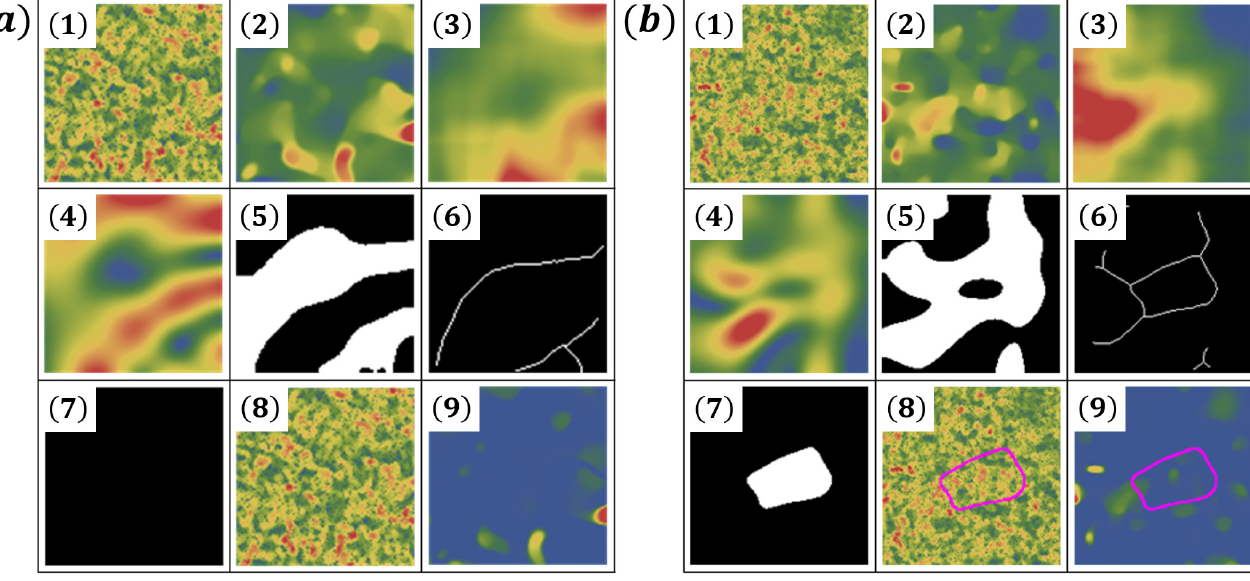
Figure 10. Instances of false positives revealed by MRIF with ( a ) no local segments found and ( b ) an artefact (purple outline) that will be eliminated later by Algorithm 6 based on the segment luminance map. Sub-figures (1–9) in ( a , b ) are: (1) is the original image projected onto an IW; (2–7) are the respective local filtering stages (Figure 9c–h); (8) is (1) with detected edge overlays; (9) is SCTMM applied to